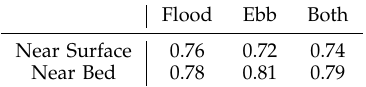
TABLE V N ORMALISED DAMAGE EQUIVALENT LOAD VALUES , USING THE MEAN PREDICTED PROFILES , DETERMINED USING AGGREGATE LOAD CYCLES FOR EACH FLOW SPEED WITH CONSTANT TURBULENCE .